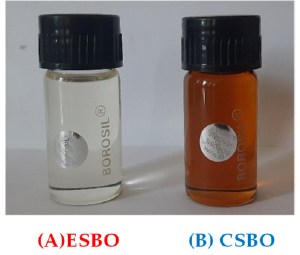
Figure 1. Images of ESBO and CSBO Resin .